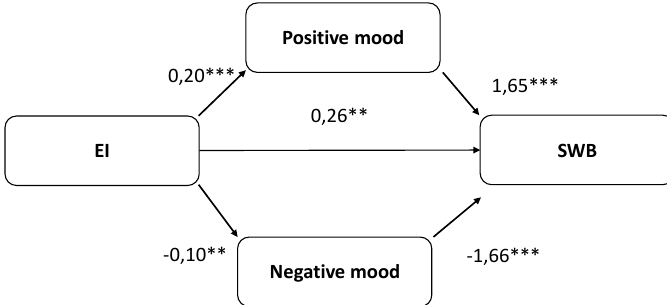
Figure 1. Summary of results of the model in total sample. Non-standardized coefficients are reported.